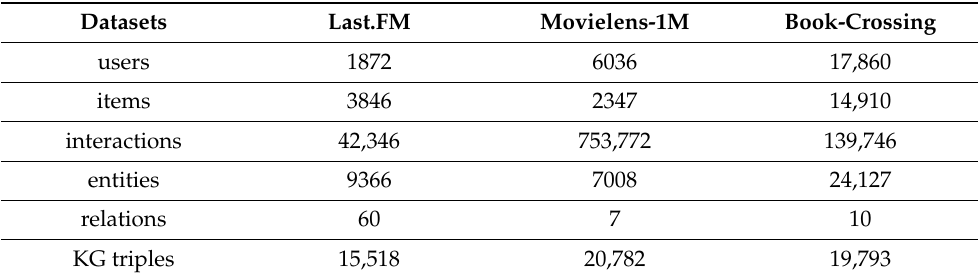
Table 1. Information of